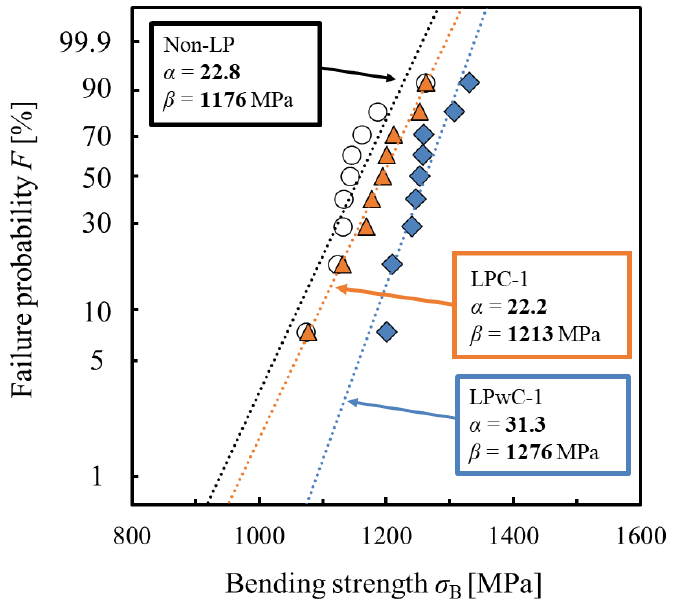
Figure 10. Weibull distribution of the non-LP and LP specimens.